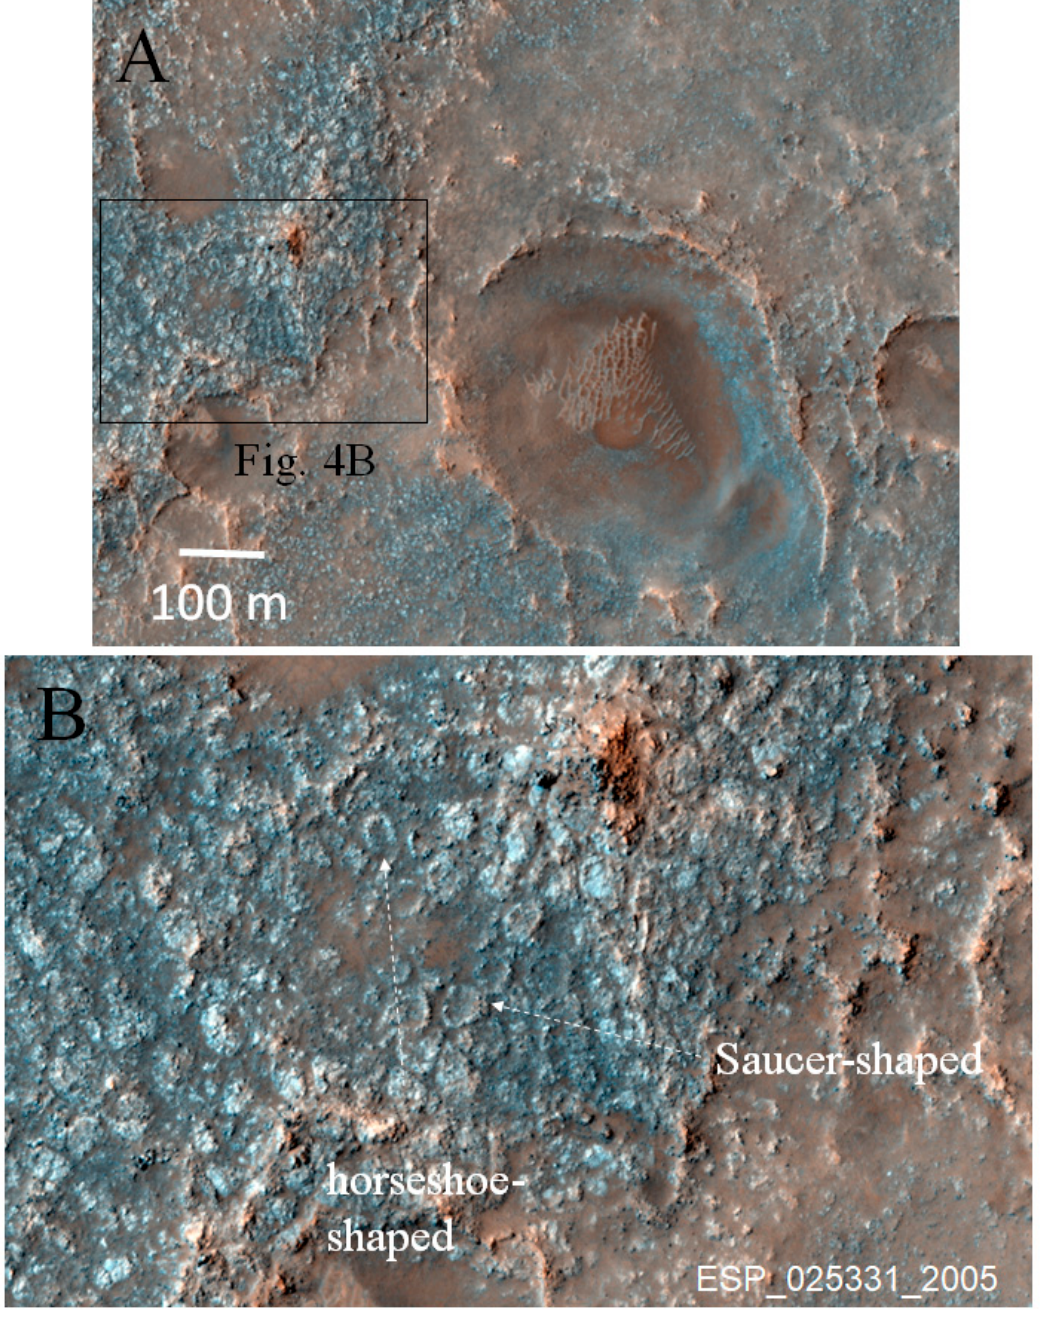
Figure 4. ( A ) This HiRISE image of the ESP_025331_2005 frame shows that the dendrites in the southeastern portion of the crater are made up of tabular units (most with subrounded outline), each approximately 15–18 m in size. The area in the rectangle is further enlarged in ( B ) to show that most of the tabular subunits are depressed in the center (“saucer-shaped”) and some of them are